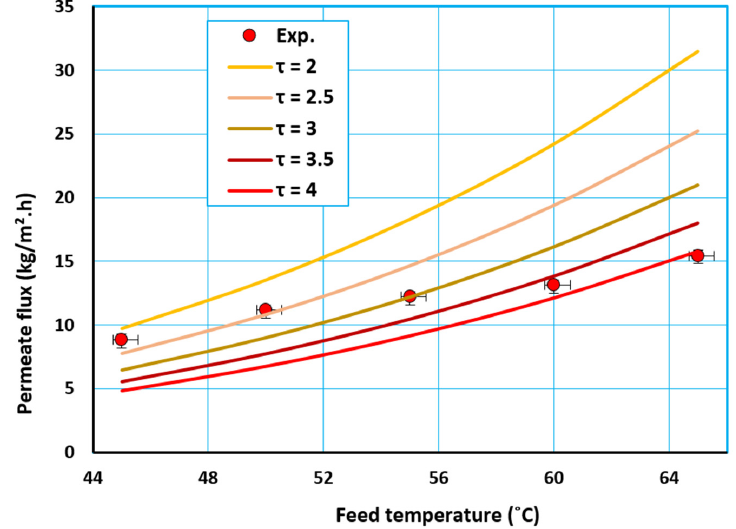
Figure 10. Effect of the feed temperature on the permeate flux at various tortuosity levels predicted by the model with the experimental data at a feed concentration of 35 g/L NaCl and a feed flow rate of 1.07 L/min.